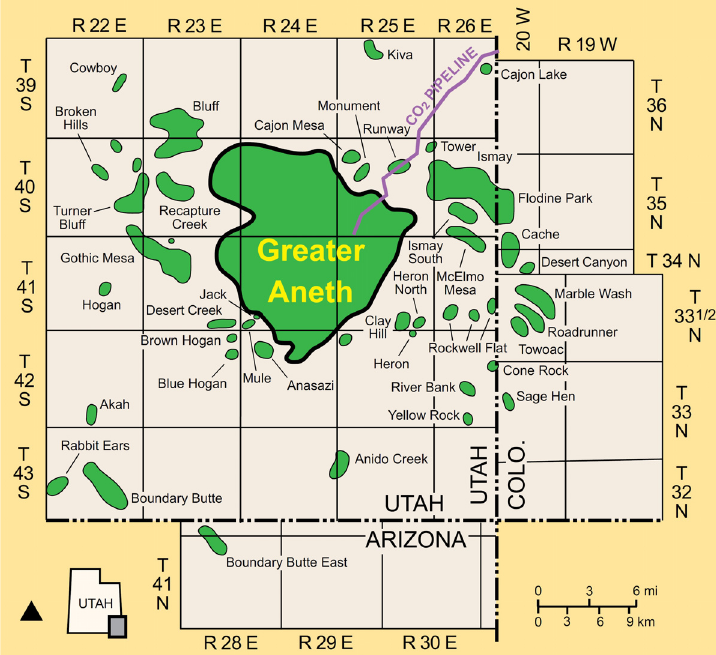
Figure 1. Location of the Greater Aneth oil field